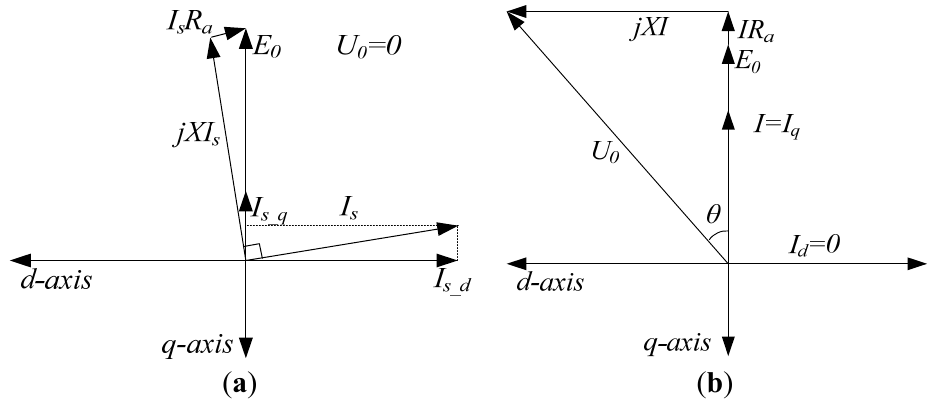
Figure 15. Vector diagram for PMSM with 1.0 per unit short-circuit current: ( a ) short circuit; and ( b ) normal